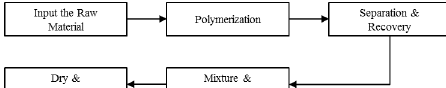
Table 2. Summary of recent studies on vulcanization. Category of Research